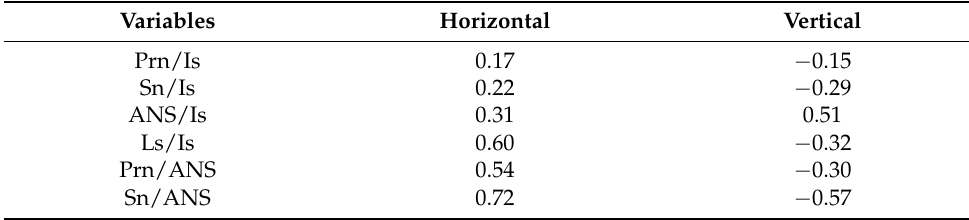
Table 4. The horizontal and vertical soft/hard tissue ratios. Variables